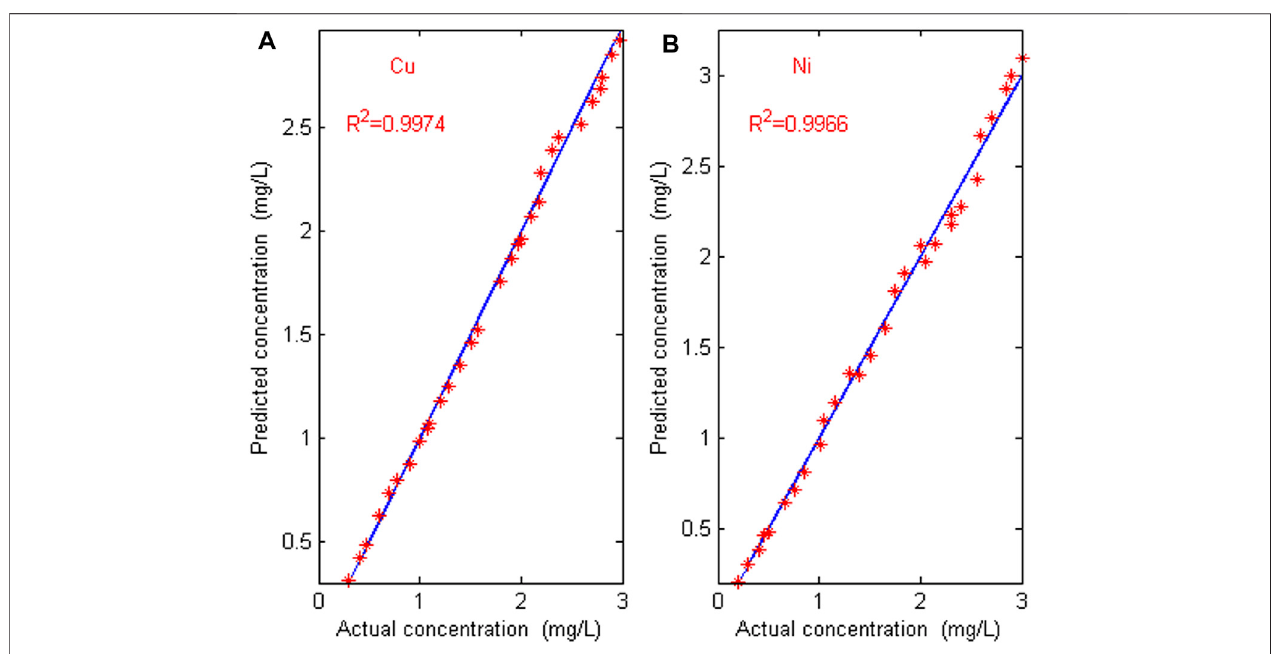
FIGURE 7 | Error graph between predicted value and actual value. (A) The error graph of Cu; (B) the error graph of Ni.